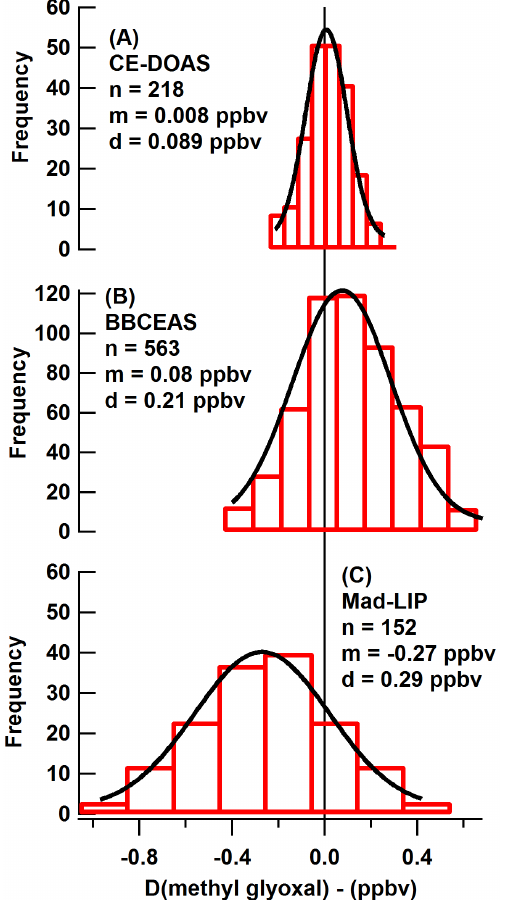
Figure 10. Histograms of methyl glyoxal baseline variability in ex- periment E8b after 02:00UTC. The number of points in the distri- bution ( n ), the mean ( m ) in ppbv and 1 standard deviation ( d ) of the distribution are listed in each panel ( a : CE-DOAS; b : BBCEAS; c : Mad-LIP). Histogram distributions are used to calculate experi- mentally determined limits of detection as LOD exp = 3 × d +| m |